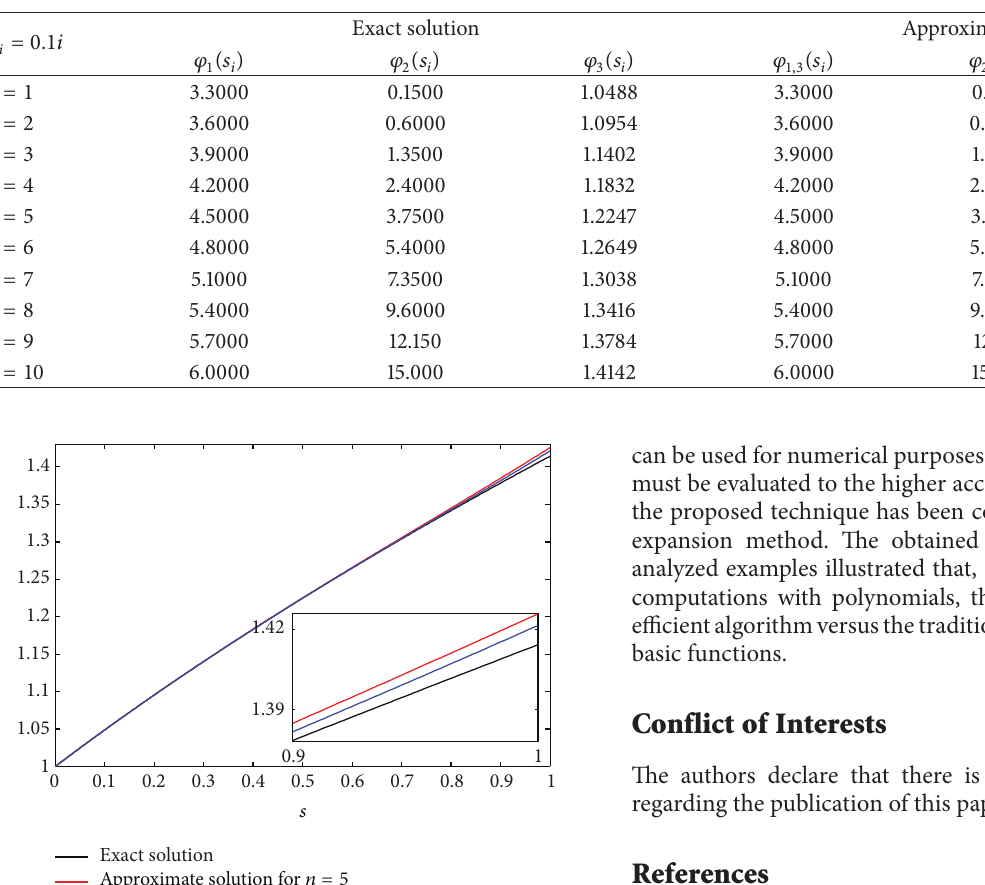
with the exact solutions 𝜑 1 (𝑠) = 3(𝑠 + 1) , 𝜑 2 (𝑠) = 15𝑠